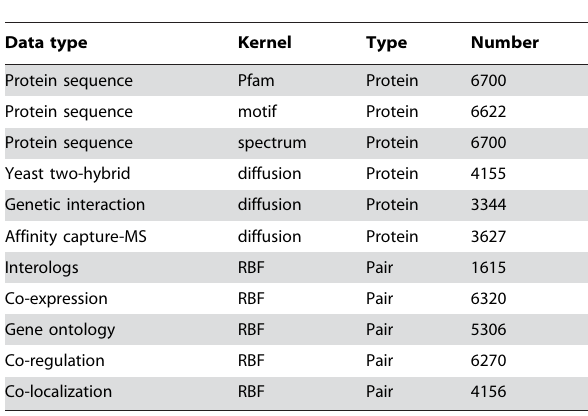
Table 1. Data types used in this